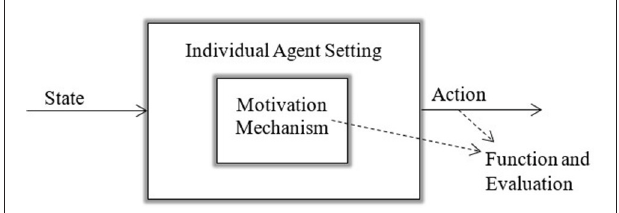
FIGURE 1 | Visualization of the relationship between Setting, Mechanism, Function, and Evaluation. The setting is the artificial intelligence framework wrapped around the motivation mechanism. The motivation mechanism influences the action of the agent, which together produces a measurable function.